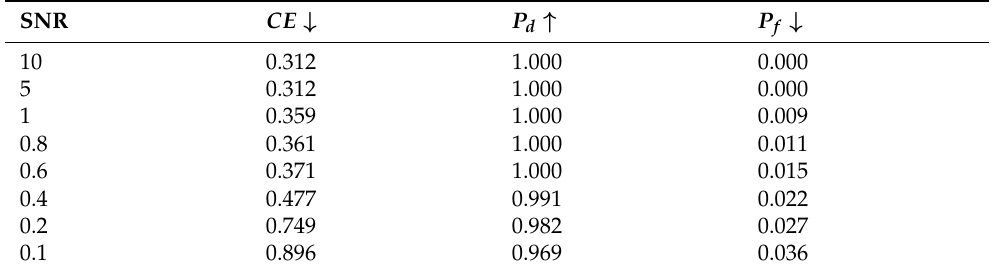
Table 8. Detection results of SDebrisNet on the SDD dataset with different